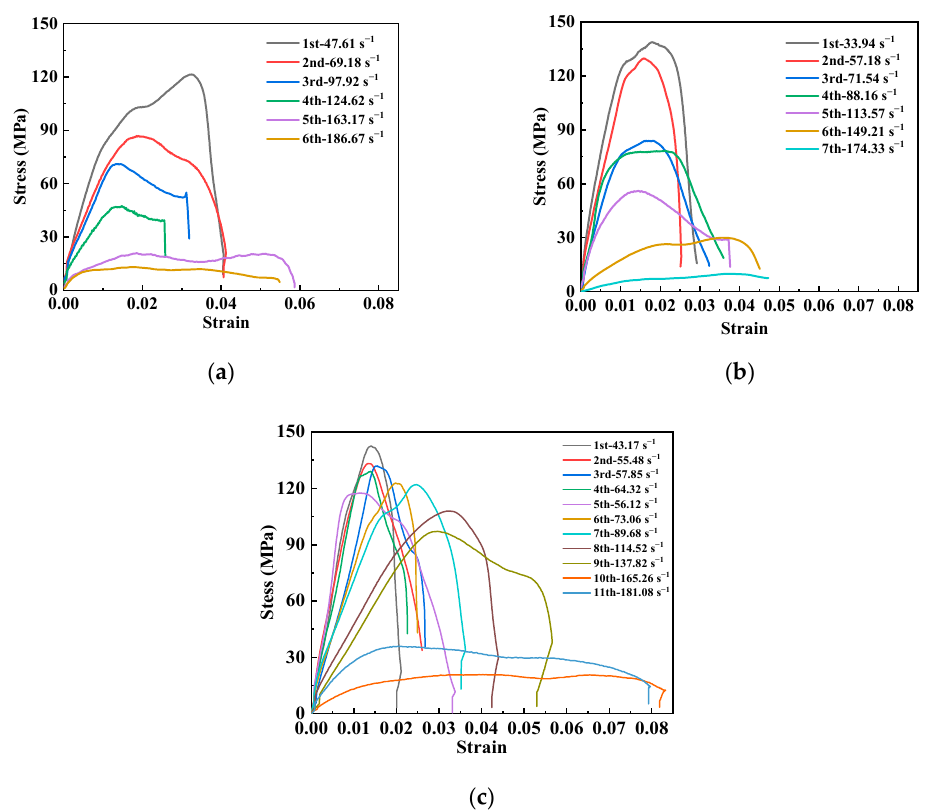
Figure 11. Stress–strain curves of non-oriented multiple-impact compression of fibers: ( a ) U-SF2; ( b ) U-SF4; and ( c ) U-SF6.